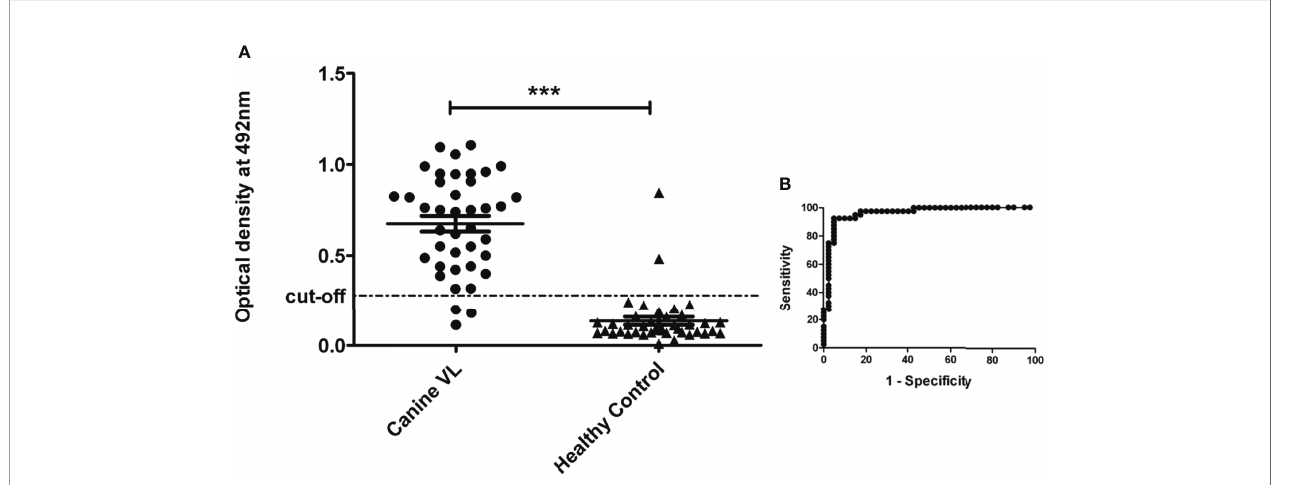
FIGURE 1 | Indirect ELISA to detect antibodies in canine sera against leishmanial antigen LAg. (A) Brazilian CVL samples (n = 40) and healthy dogs sera (n = 40) were used in this study. Each dot represents an average value of a single sample. The signi fi cance between the groups was obtained as p < 0.0001 (***). (B) Cutoff was selected according to the receiver operator characteristic (ROC) curve obtained from GraphPad Prism 5.